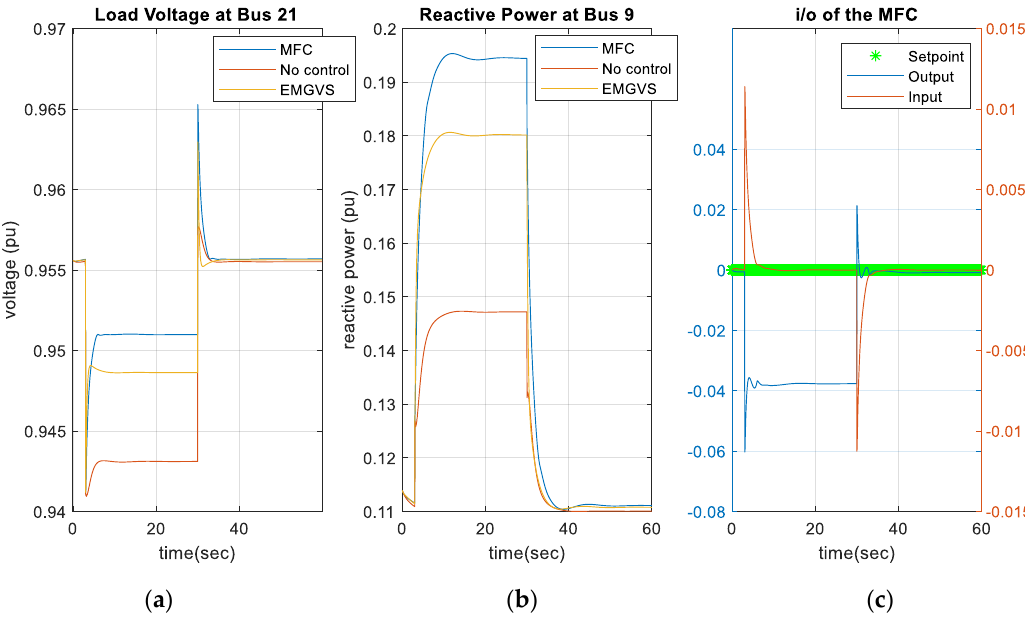
Figure 17. Simulation results for the IEEE 21-bus microgrid system with all SG-based DERs under a 25% load increase at all load buses ( Case 3 )—( a ) load voltage at bus 21; ( b ) reactive power at bus 9; and ( c ) i/o of the MFC.